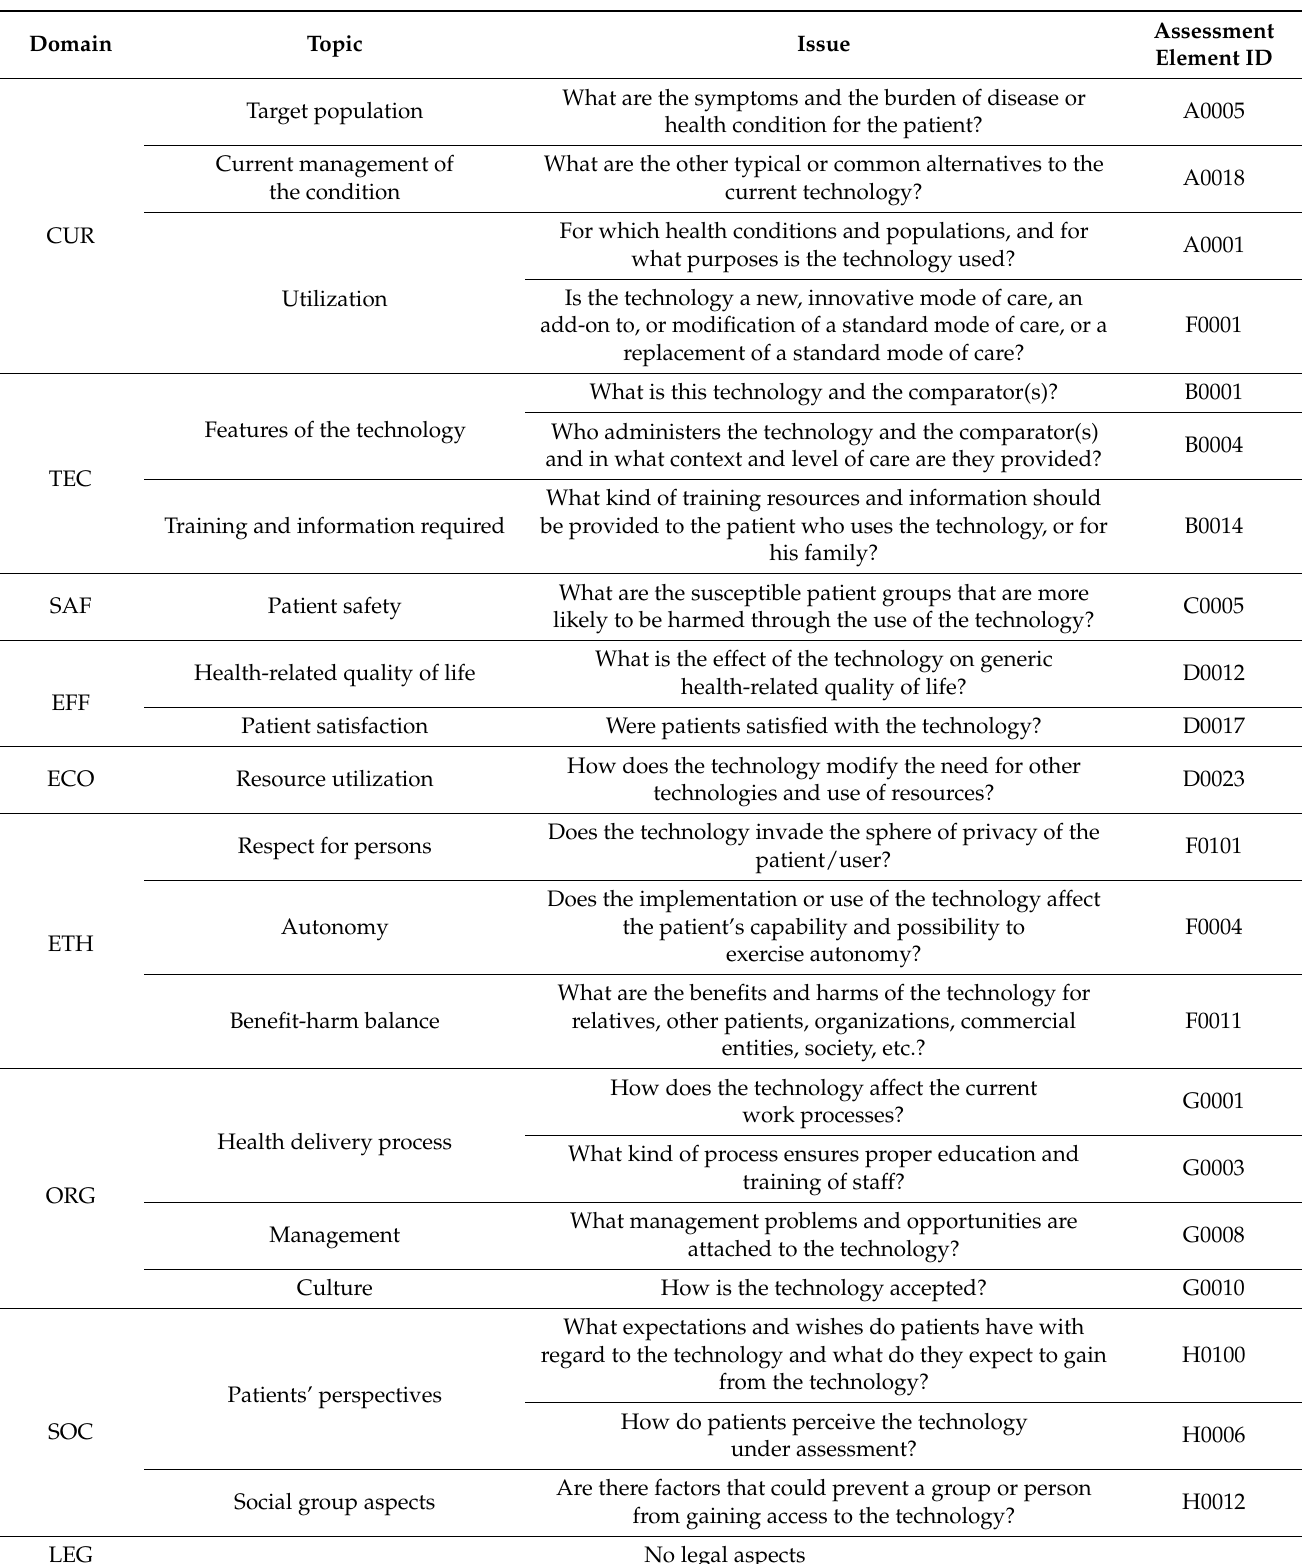
Table 3. Summary of the 21 EUnetHTA Core Model issues